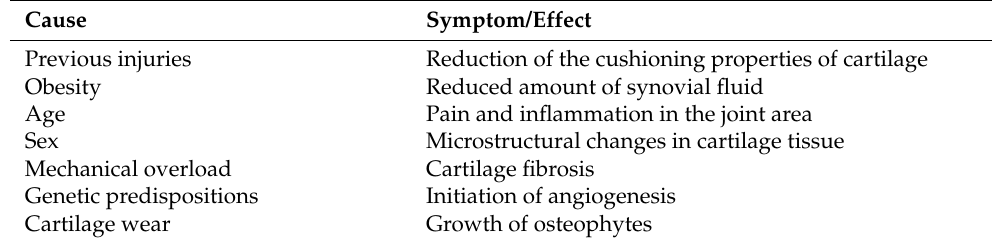
Table 1. Causes and effects of osteoarthritis.